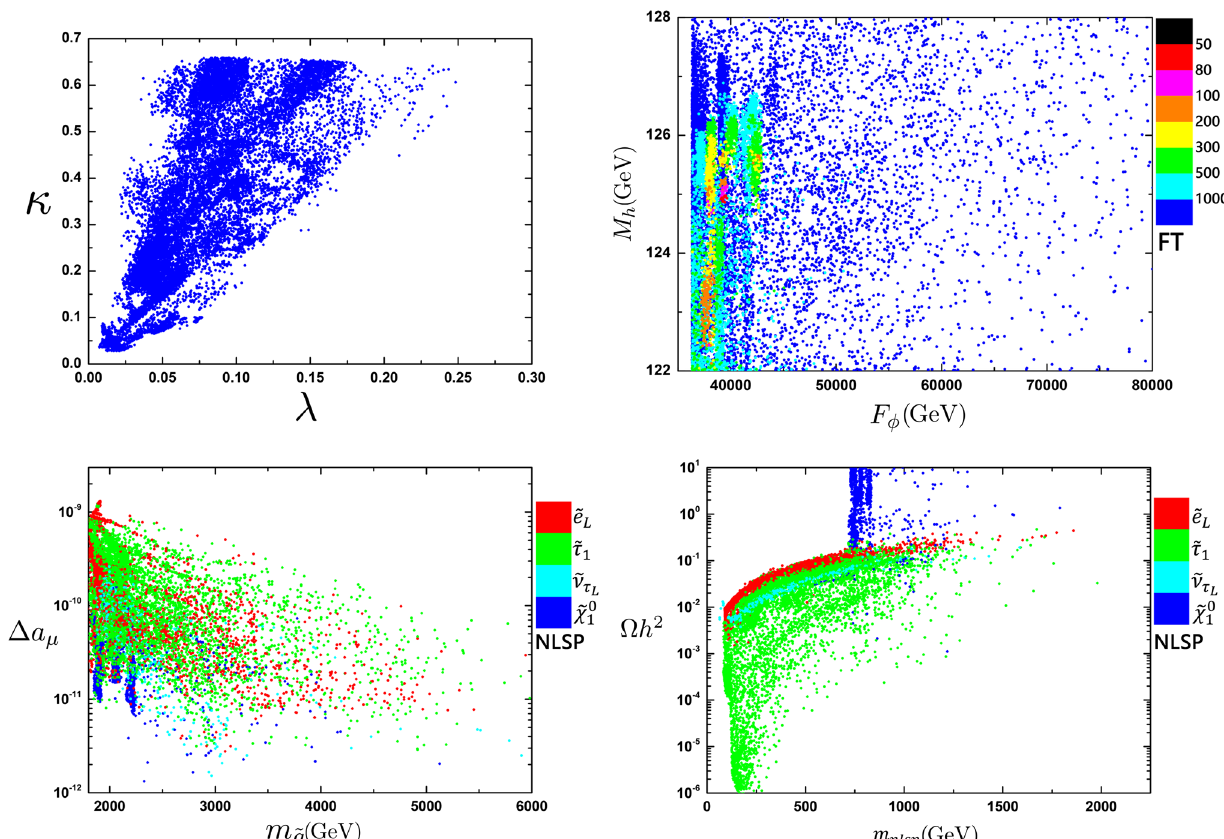
Fig. 2 Numerical scan for scenario II with axino LSP. All points can satisfy the collider constraints (i) to (iv). In the upper left panel, the allowedvaluesfor λ vs κ arederivedfromEWSBconditionofNMSSM; in the upper right panel, the allowed ranges of F φ vs m Higgs are shown explicitly. The involved Barbieri-Giudice fine tuning are also shown;